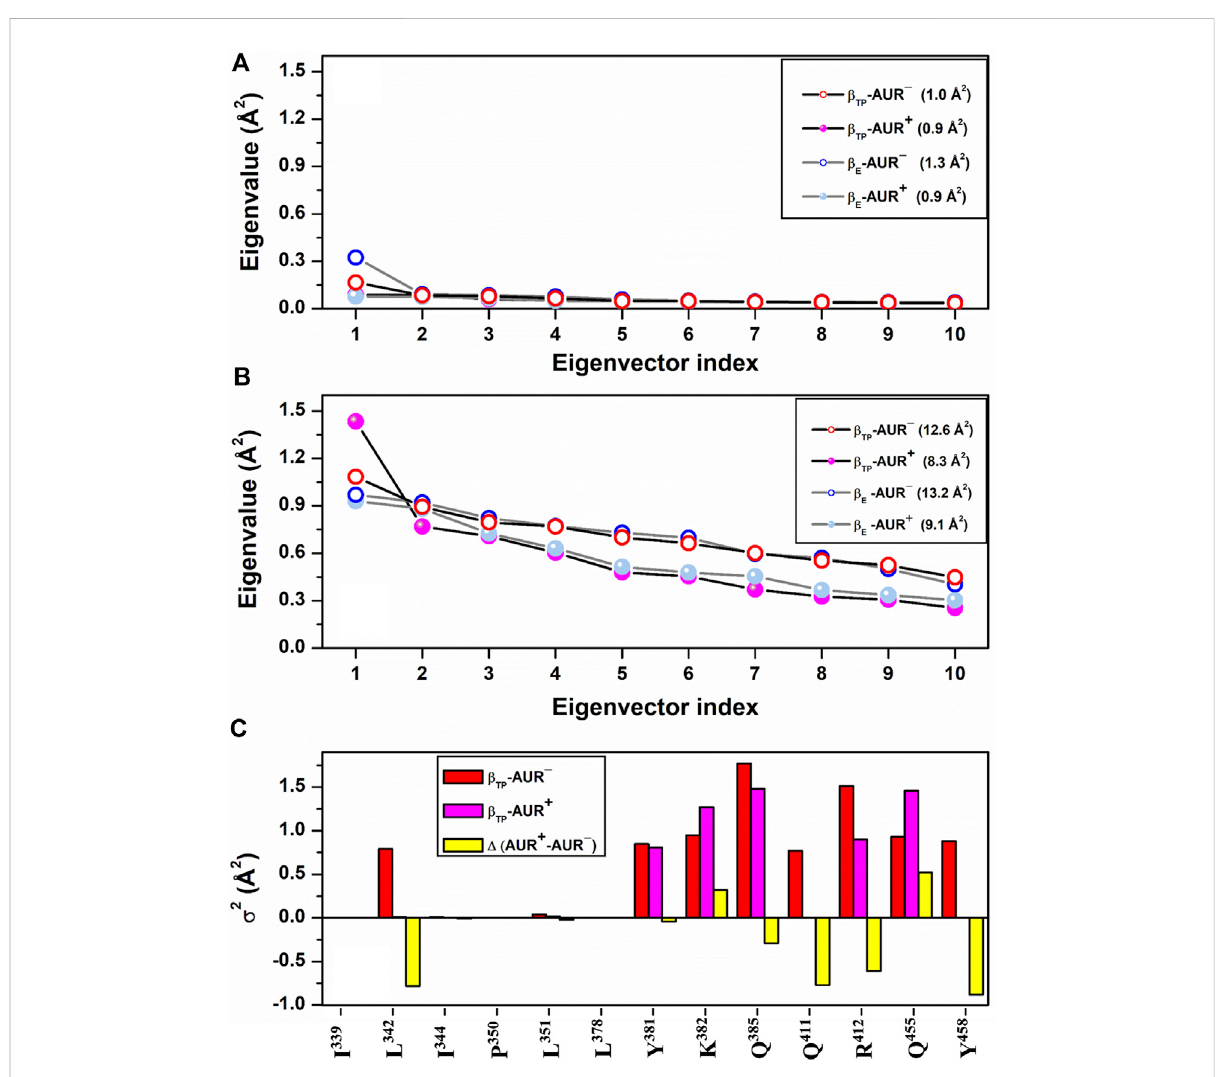
FIGURE 5 dPCA scree plots for AUR binding residues. The eigenvalue distributions for the fi rst ten eigenvectors for backbone and side chain dihedral angles are shown in (A) and (B) , respectively. Values in parentheses indicate the total variance for the indicated system. (C) Cumulative variance